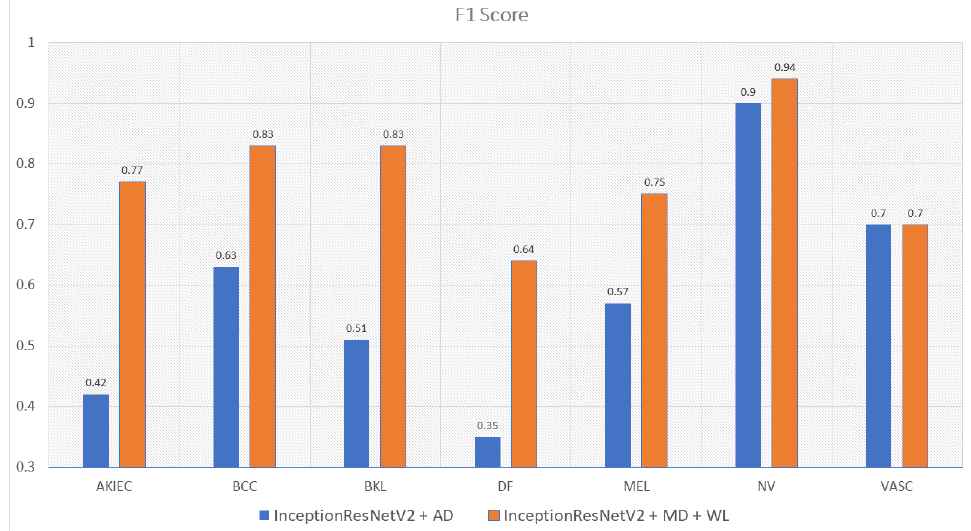
Figure 13. The comparison between F1-scores of InceptionResNetV2 trained with augmented data and the one trained with metadata and weight